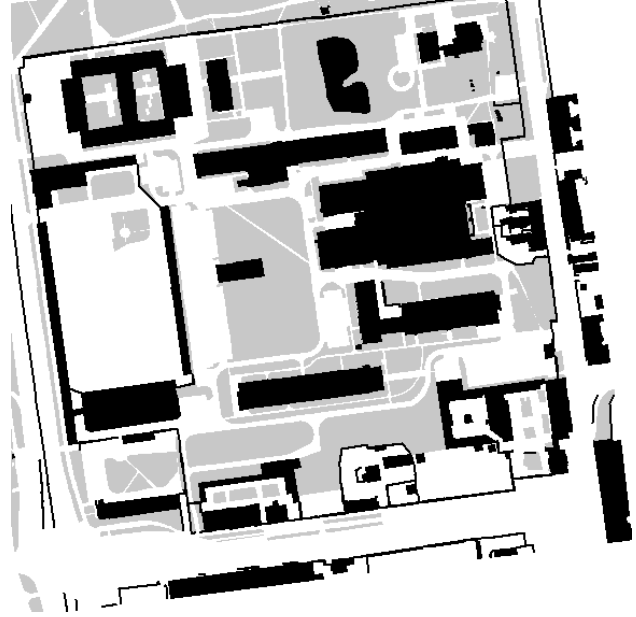
Figure 8. An example of a probability map of the University Campus. Forbidden, probable and preferred areas are denoted by black, grey and white respectively. The streets at the campus are paved and have the same texture as pavements. A blind user would rather refrain from walking through